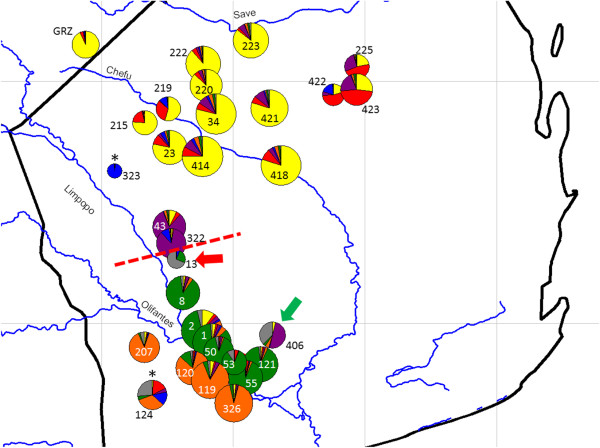
Genetic variation of nuclear microsatellites assessed using STRUCTURE. Pie chart colours represent the proportional membership of individuals to microsatellite-based clusters inferred from the model for K = 7 (this model is well supported by Evanno et al. approach and provides detailed substructuring; see also Additional file 3). The dashed red line indicates the border between the Chefu and Limpopo haplogroups. The diameter of the pie charts is related to allelic richness (except the captive population GRZ, which is not scaled). Asterisks indicate populations with probable inbreeding (deficit of heterozygotes at four loci; Pop323 and Pop124); the red arrow indicates a population showing a significant bottleneck (Pop13); green arrow indicates secondary contact of two mtDNA lineages (Pop406).